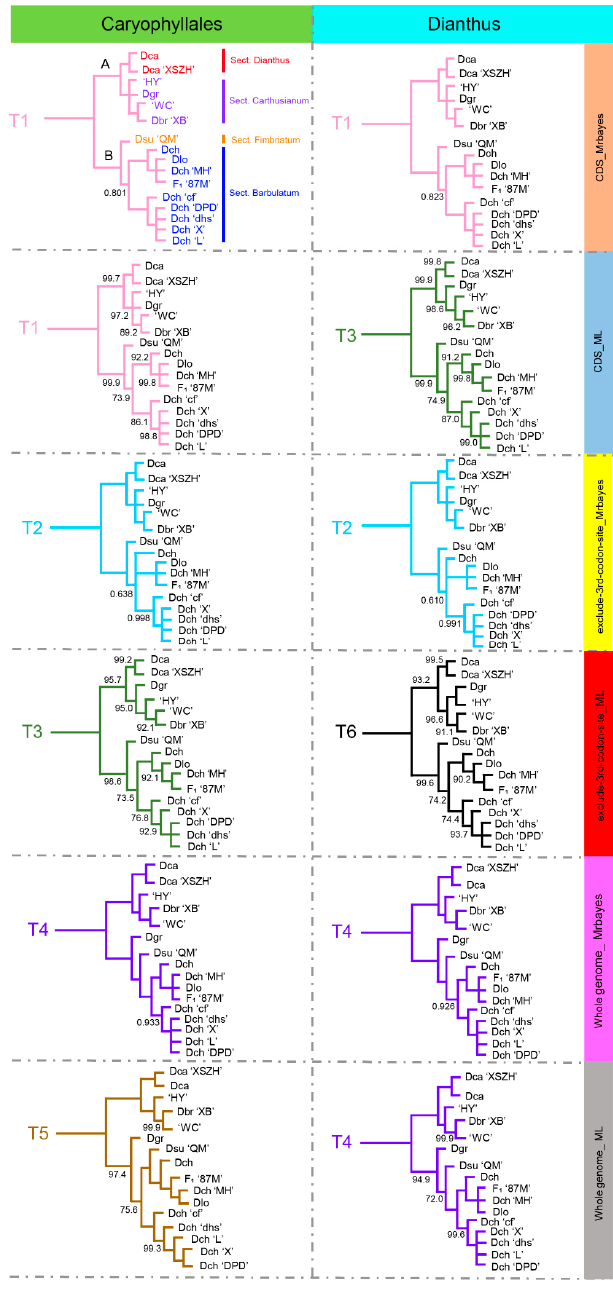
Figure 6. Twelve topologies for 16 Dianthus species based on six datasets from Caryophyllales and Dianthus chloroplast genomes. The six topologies on the left used 46 Caryophyllales species. The six topologies on the right used 16 Dianthus species and two outgroups. The label on the right indicates the type of dataset used and the method of constructing the tree. The same color represents the same topology. For all trees, unlabeled nodes have 100%